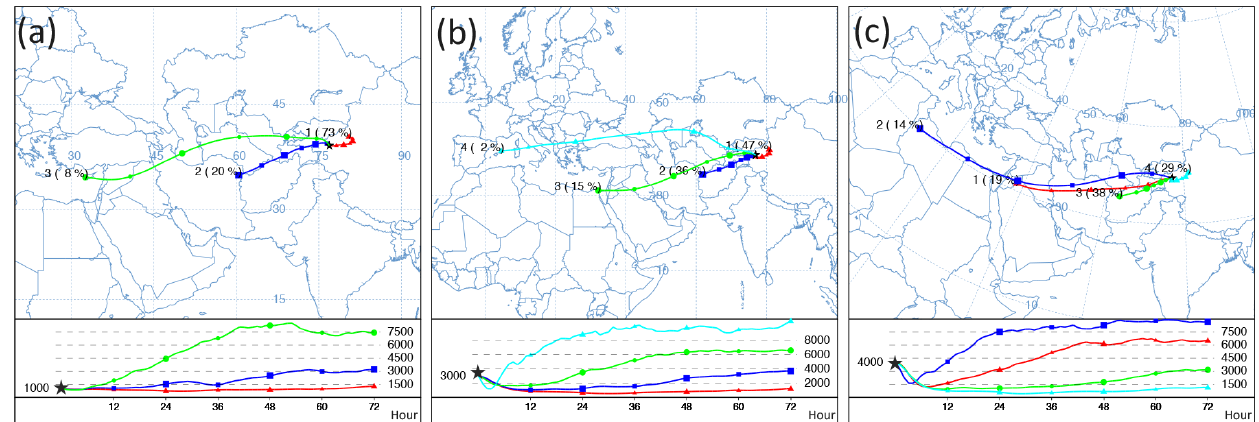
Figure 14. The clustering of air masses in April 2019. The clustering is performed using HYSPLIT and based on back trajectories with a 2h time resolution and 72h duration. (a) 1000m, (b) 3000m and (c) 4000m. Table 2. A summary of optical properties derived from lidar observations in the case studies. The values before the “ ± ” symbol represent the mean in the range of the layer height. The values after the “ ± ” symbol represent the statistical error of the values before the symbol. Case